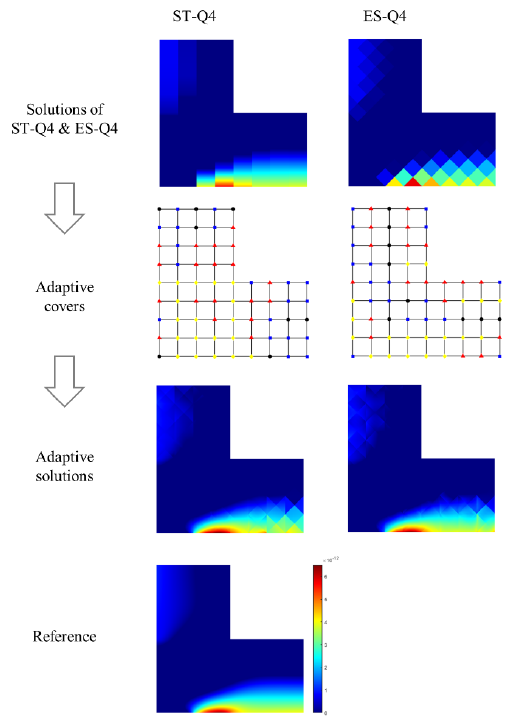
Figure 14. von Mises ( τ ) predictions obtained by the standard and edge-based smoothed four-node quadrilateral finite elements (ST-Q4 and ES-Q4) and the adaptive enrichment scheme for the L-shape structure problem when the Mesh I is used.